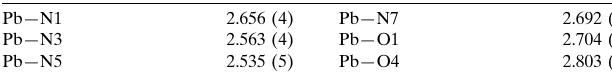
Selected bond lengths (A˚ ).